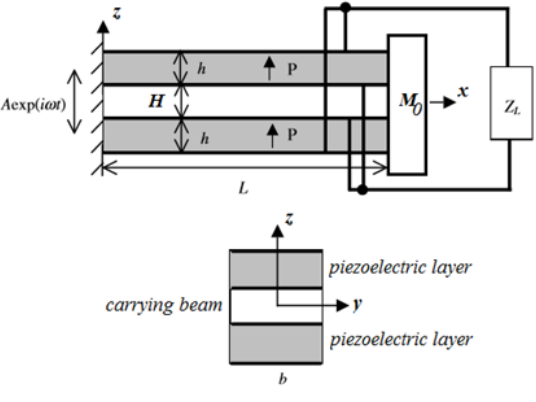
Figure A1. The piezoelectric bimorph model.